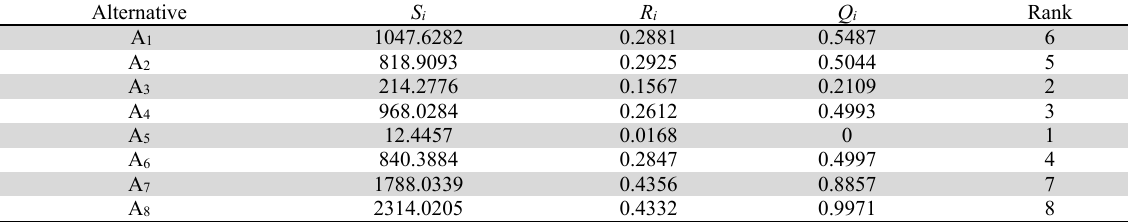
Ranking of material alternatives in regret theory-based VIKOR method